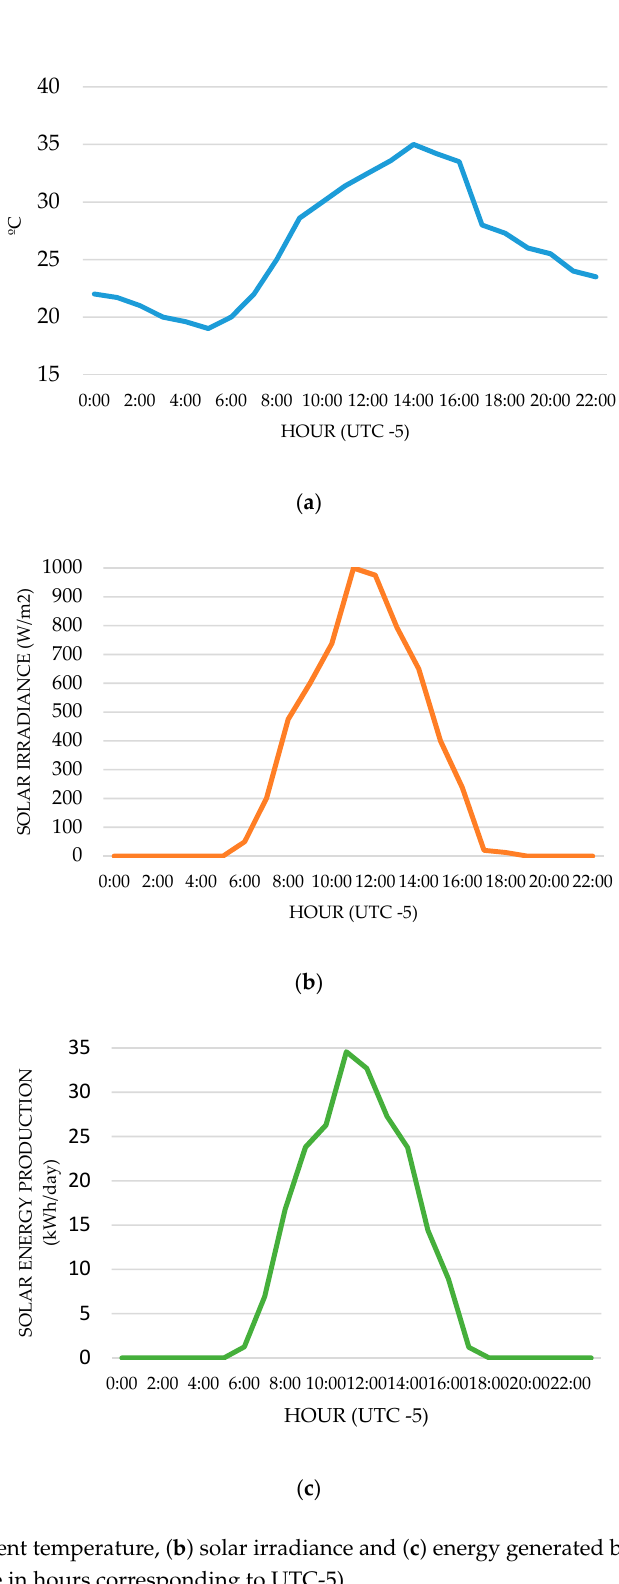
Figure 9. ( a ) Ambient temperature, ( b ) solar irradiance and ( c ) energy generated by the PV system on 18 September (time in hours corresponding to